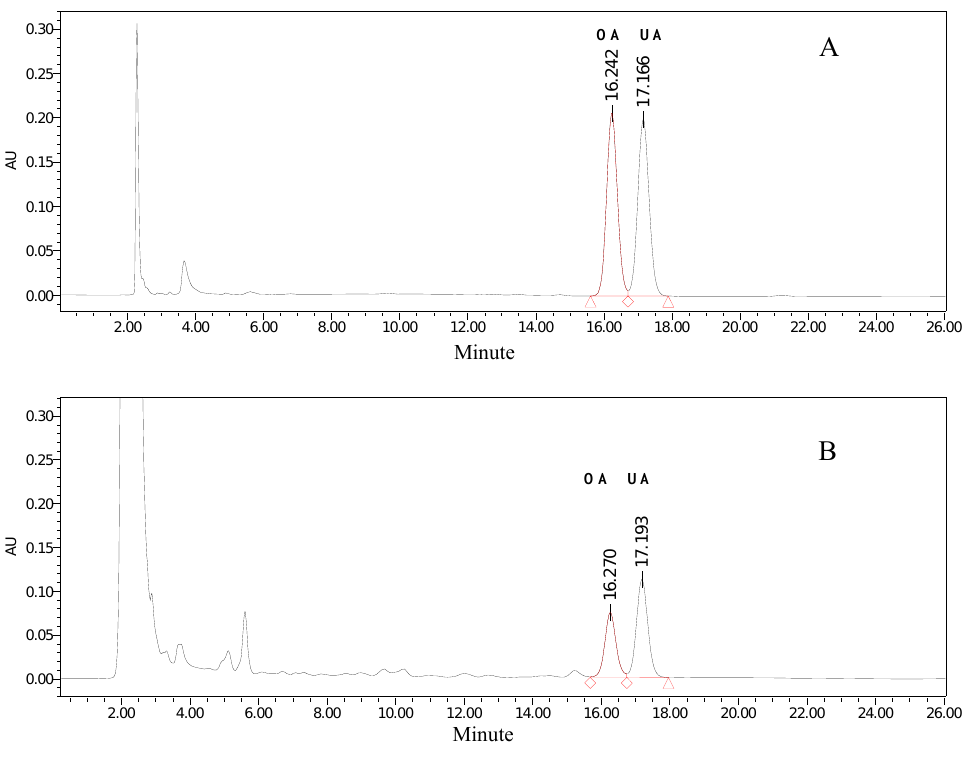
Figure 2. HPLC chromatograms of OA, UA standard (A) and the flesh extract of persimmon fruit